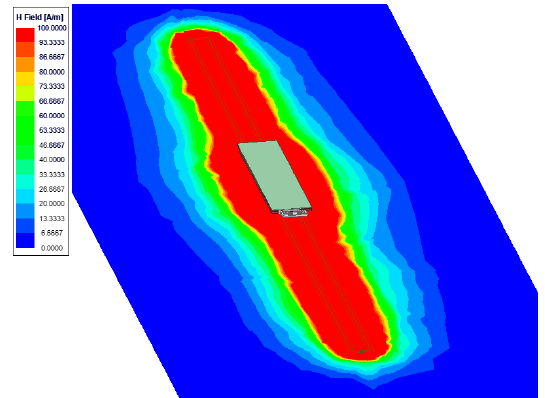
Figure 4. Structure of the power line and pick-up for EMF simulation.